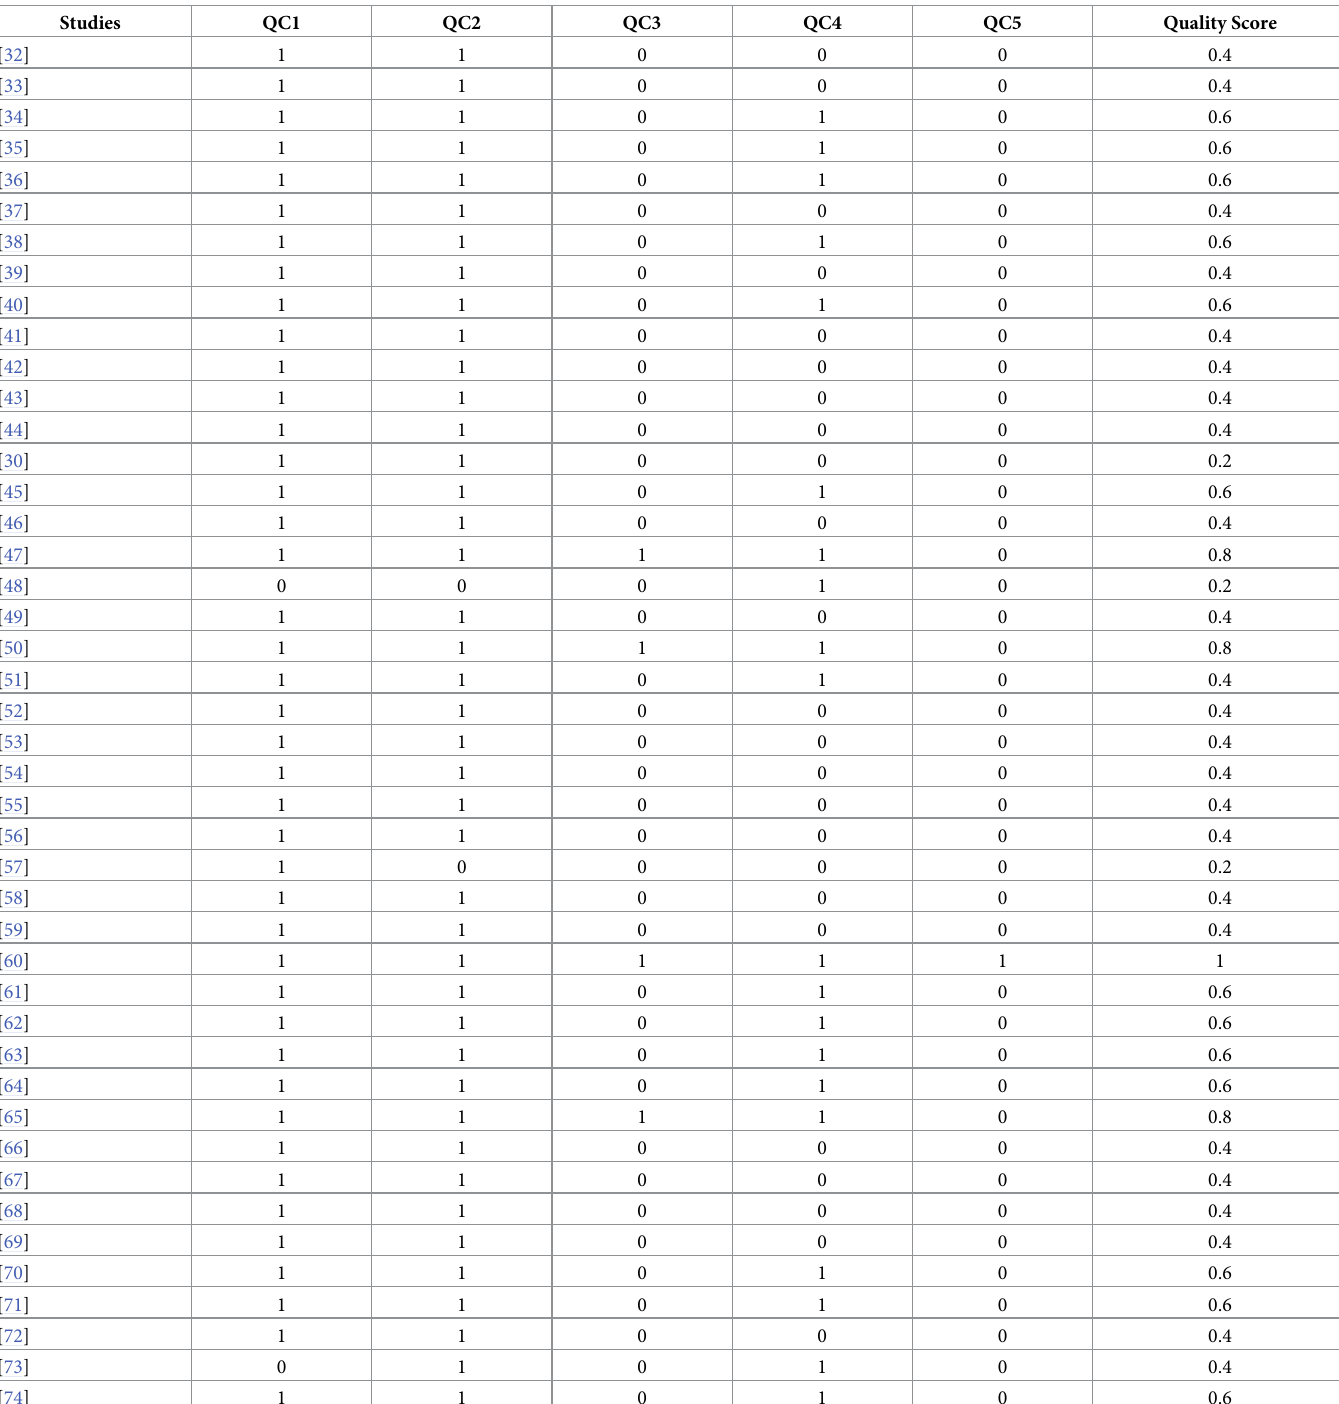
Table 1. The quality scores of the selected